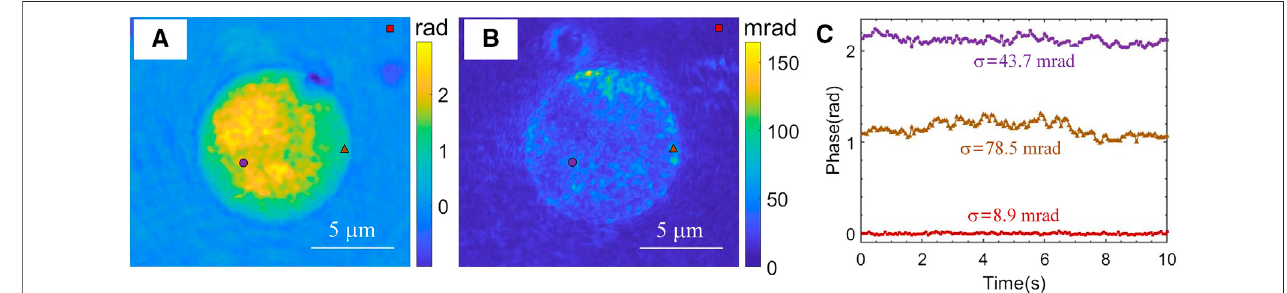
Frontiers in Physics |